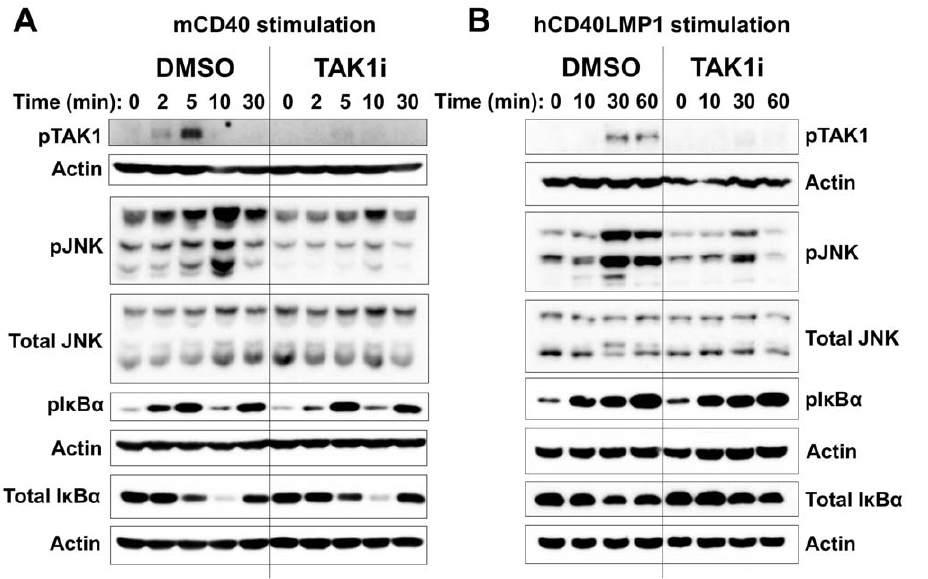
Figure 3. Role of TAK1 in CD40 and LMP1 early signaling events. A) Mouse CH12.LX B cells were treated with DMSO or TAK1i for 30 min prior to stimulation with anti-mCD40 Ab for 0, 2, 5, 10, or 30 min. Western blots show pTAK1, pJNK, pI k B a , and total I k B a , with total JNK and actin as loading controls. B) Similar to panel A , except that CH12.hCD40LMP1 mouse B cells were stimulated with anti-hCD40 Ab for 0, 10, 30, or 60 min. Data shown are representative of three independent